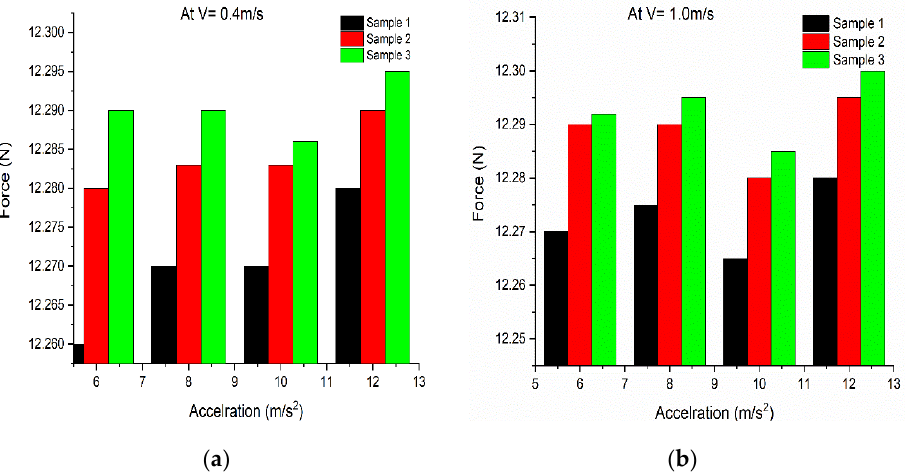
Figure 8. Effect of acceleration excitations on the peak force of the cluster during vertical transpor- tation at different speeds, such as ( a ) 0.4 m/s; ( b ) 1.0 m/s.